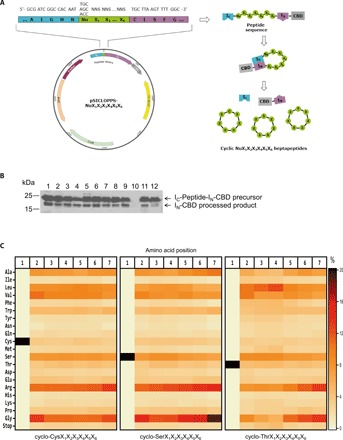
Construction and characterization of a combinatorial cyclic heptapeptide library with expanded diversity.(A) Left: Representation of the pSICLOPPS-NuX1X2X3X4X5X6 vector library encoding the combinatorial heptapeptide library cyclo-NuX1X2X3X4X5X6. Nu: Cys, Ser, or Thr; X: any of the 20 natural amino acids; NNS: randomized codons, where N = A, T, C, or G and S = G or C; IC: C-terminal domain of the Ssp DnaE split intein; IN: N-terminal domain of the Ssp DnaE split intein. Right: Peptide cyclization using the SICLOPPS construct. Upon interaction between the two intein domains IC and IN, the encoded IC-NuX1X2X3X4X5X6-IN-CBD fusions undergo intein splicing and peptide cyclization, leading to the production of the cyclo-NuX1X2X3X4X5X6 library. (B) Western blot analysis of 12 randomly picked individual clones from the combinatorial heptapeptide library cyclo-NuX1X2X3X4X5X6, showing the expression and processing of the precursor fusion protein IC-peptide-IN-CBD. The 25-kDa band corresponds to the unprocessed precursor and the 20-kDa band to the processed IN-CBD construct, and indicates, wherever present, successful intein splicing and peptide cyclization. Clone 10, for which the precursor is not expressed, was to contain a stop codon in its peptide-encoding region. (C) Heatmap representation of the amino acid distribution at each position of the constructed cyclo-CysX1X2X3X4X5X6 (left), cyclo-SerX1X2X3X4X5X6 (middle), and cyclo-ThrX1X2X3X4X5X6 (right) sublibraries, as demonstrated by the deep sequencing analysis results.